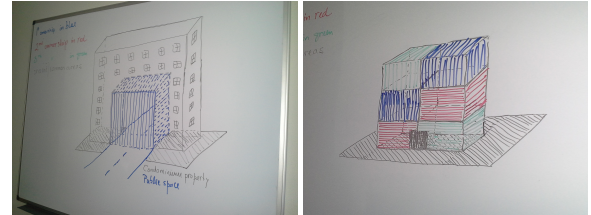
Figure 2: Property and Land Ownership Sketches - Left: Private property built over a public road, Right: Block of apartments, each having a different owner with the land having a different owner, surrounding the property on all sides